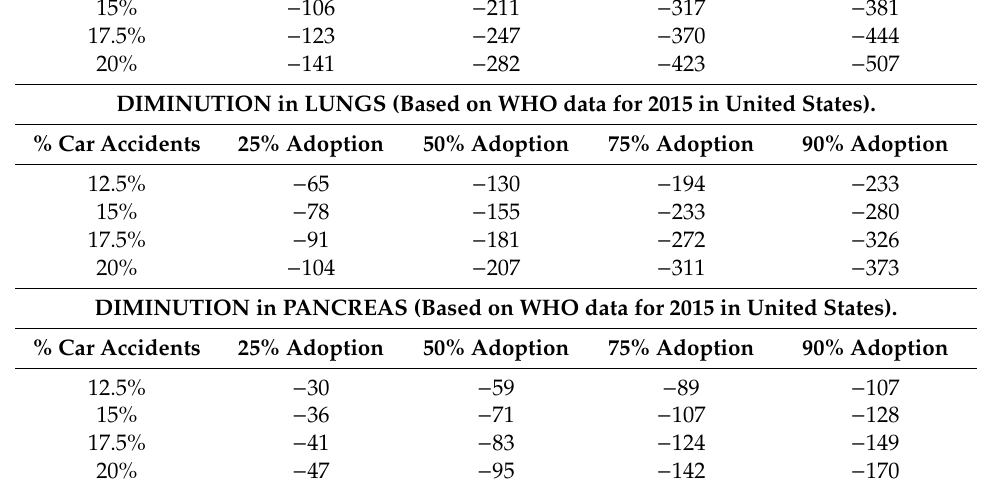
DIMINUTION in HEARTS (Based on WHO data for 2015 in United States). % Car Accidents